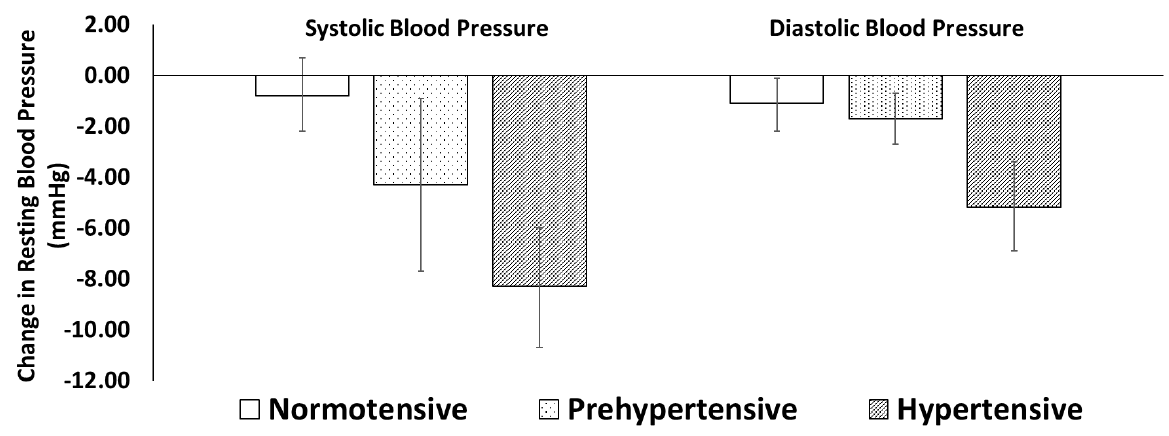
Figure F10-6. Blood Pressure Response to 16 Weeks of Aerobic Physical Activity, by Resting Blood Pressure